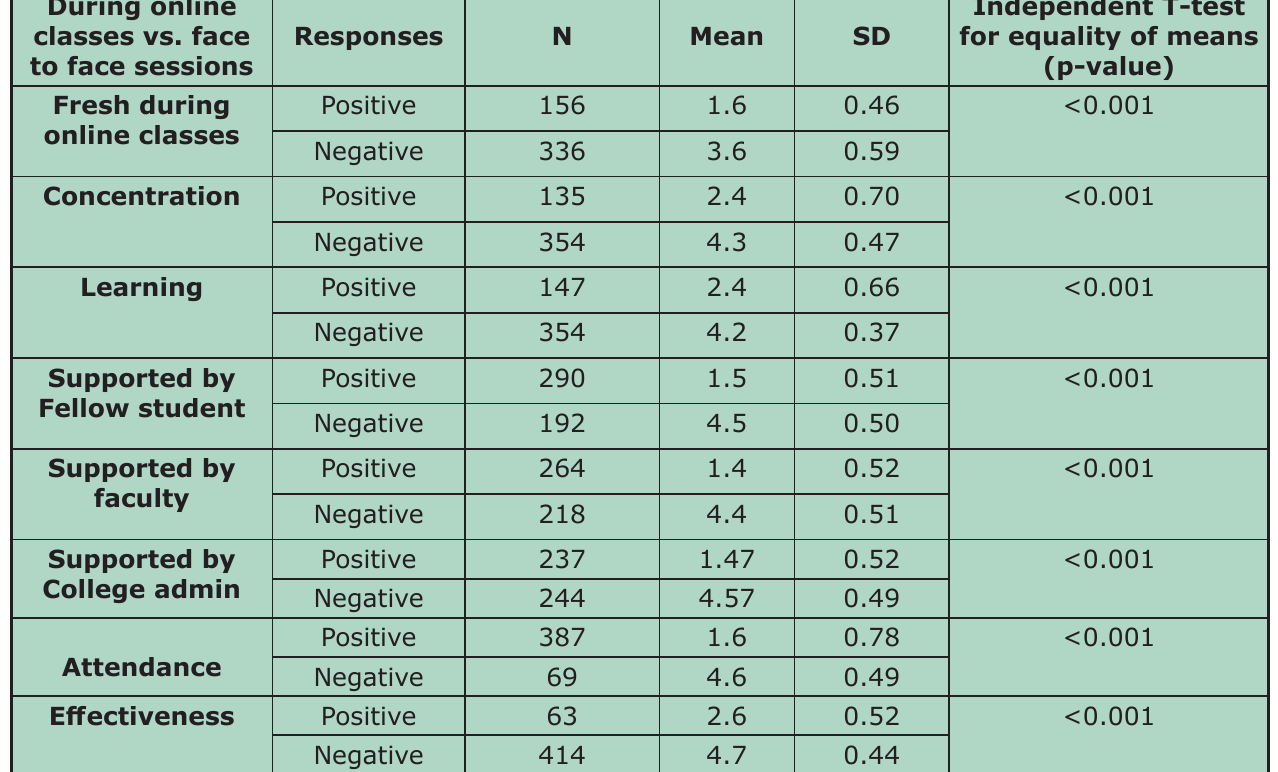
Table-I: Students perspectives and attitudes towards